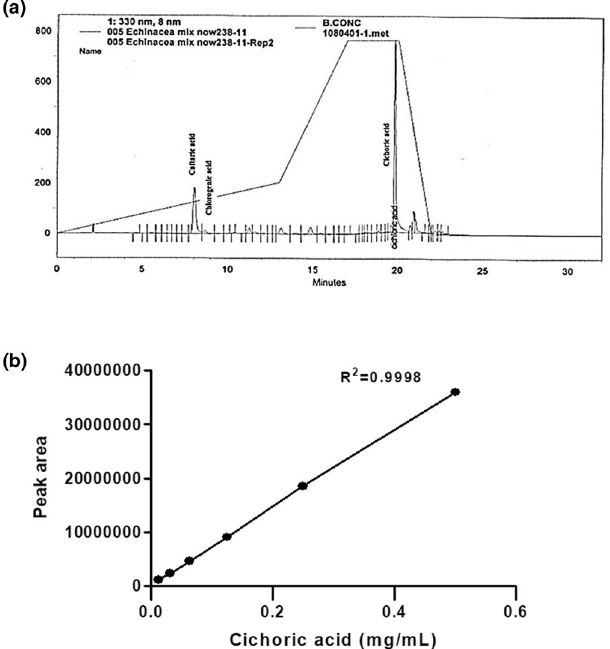
Figure 1. Determination of ( a ) total phenolic compounds in EE and ( b ) standard curve of cichoric